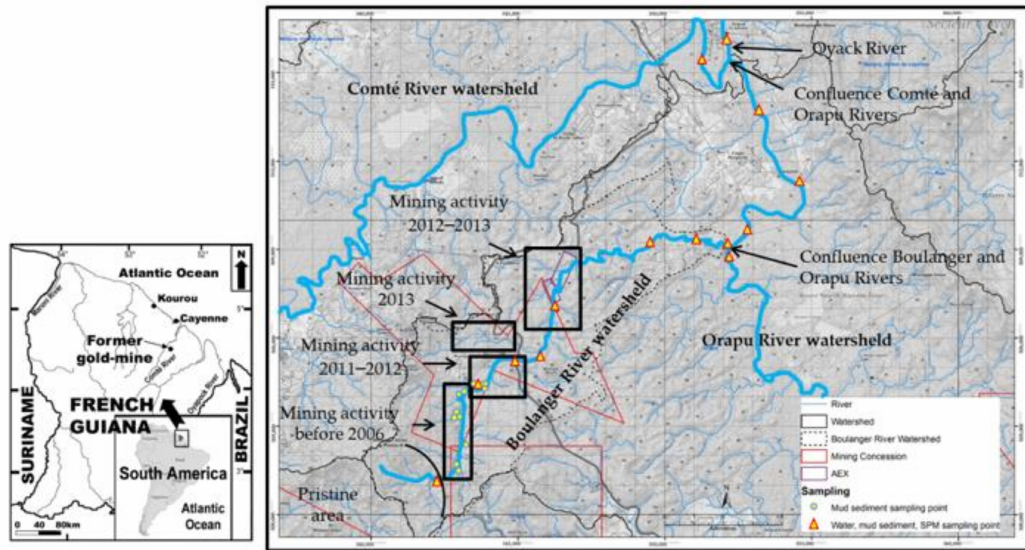
Figure 1. Map of the study area in French Guiana and the sampling points.